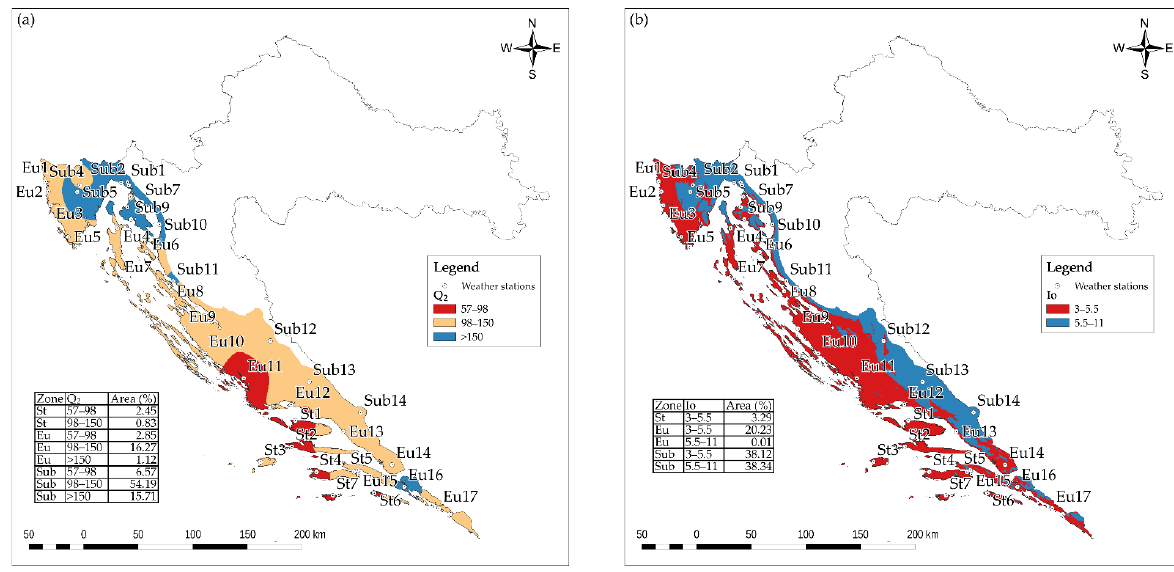
Figure 4. ( a ) Emberger pluviothermic quotient (Q 2 ), ( b ) Ombrothermic index (Io).